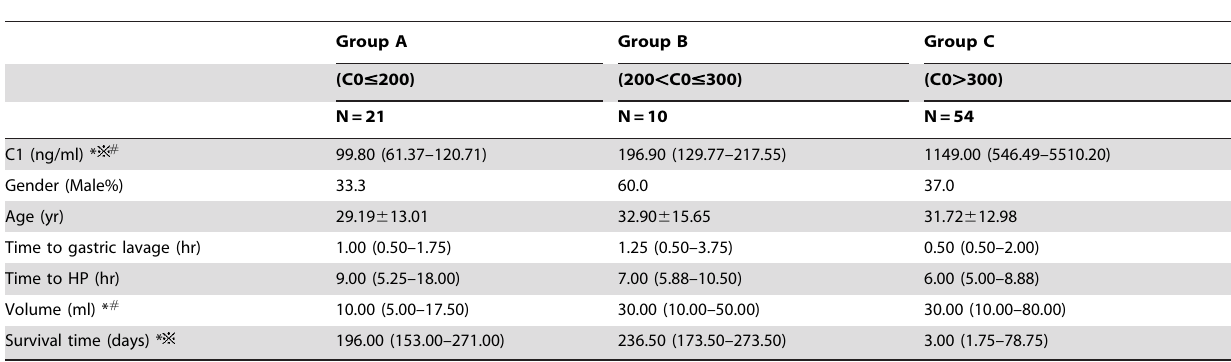
Table 1. Basic Characteristics of patients with PQ poisoning.